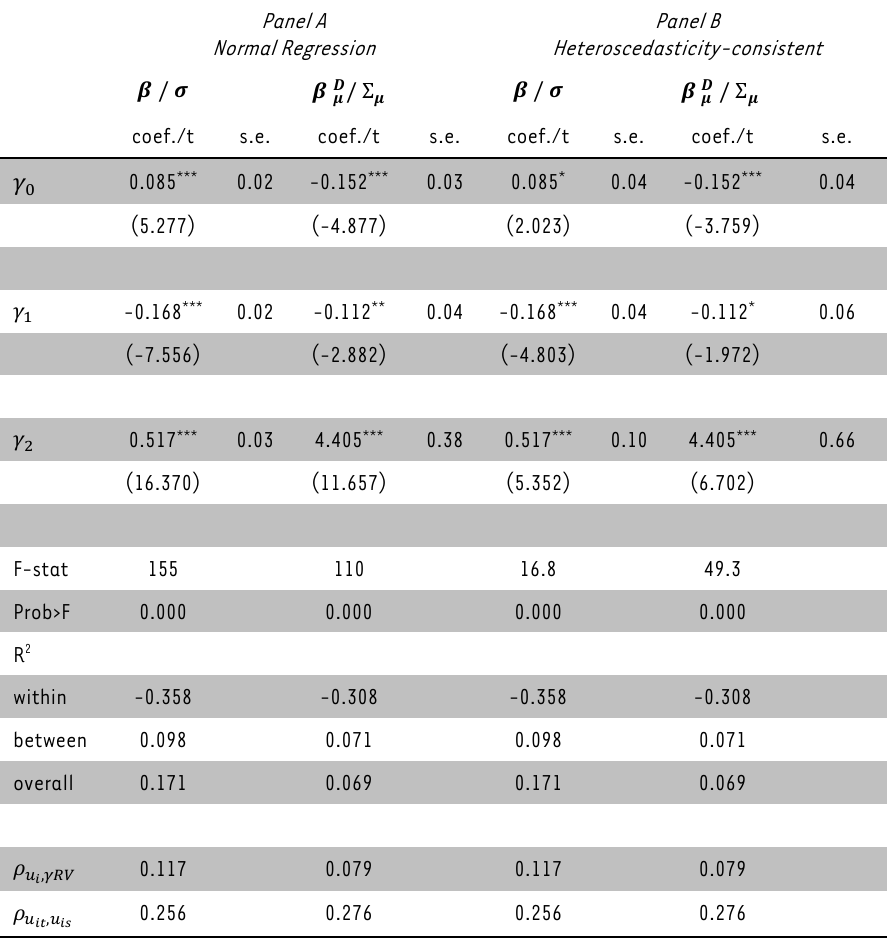
TABLE 5: Panel Data multiple Regression Results: MSB vs MVB risk variables Panel A Panel B Normal Regression Heteroscedasticity-consistent 𝜷 / 𝝈 𝜷 𝝁𝑫 / Ʃ 𝜷 / 𝝈 𝜷 𝝁𝑫 / Ʃ 𝝁 𝝁 coef./t s.e. coef./t s.e. coef./t s.e. coef./t